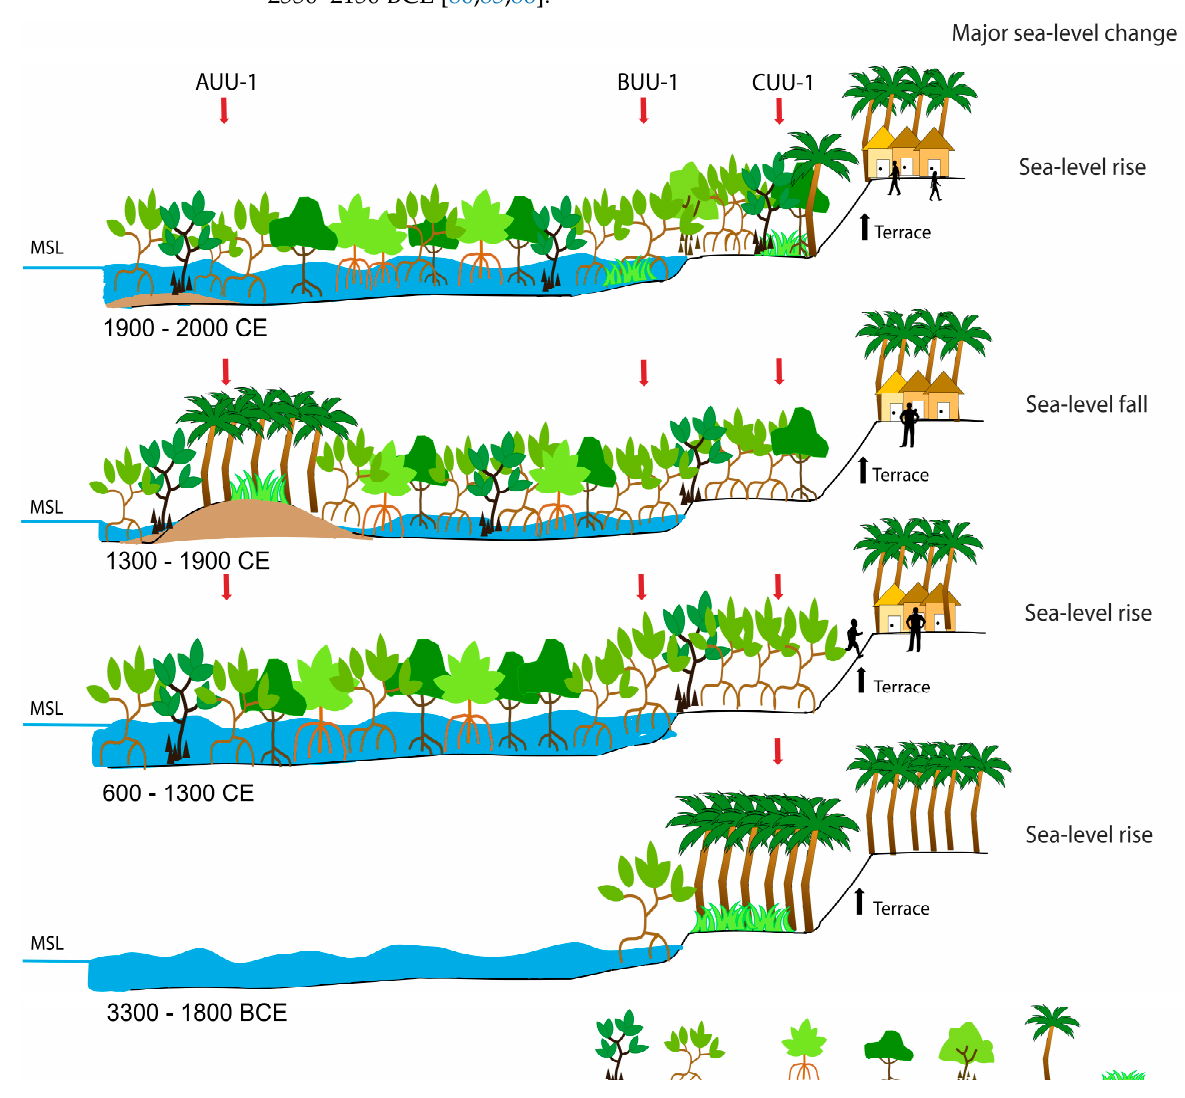
Figure 10. Schematic representation simplifying major sea-level changes recorded at Unguja Ukuu from before around 3300 BCE until the present day.